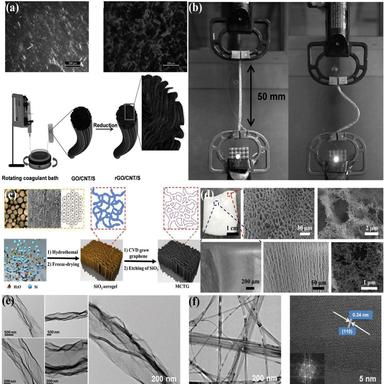
(a~b) schematic illustration of wet-spinning process of rGO/CNT/S gel fibers, cable battery powering a LED subjected to bending in compression Copyright 2016, Wiley-VCH; (c~d) Schematic of the wood-inspired design of interconnected multi-channel tubular architecture.Photograph (left), multi-channel structure (middle) and tissue (right) of wood. Schematic illustration of the synthetic procedure of MCTG, Photograph of a SiO2 aerogel. SEM images of top-view and cross-sectional view of SiO2 aero